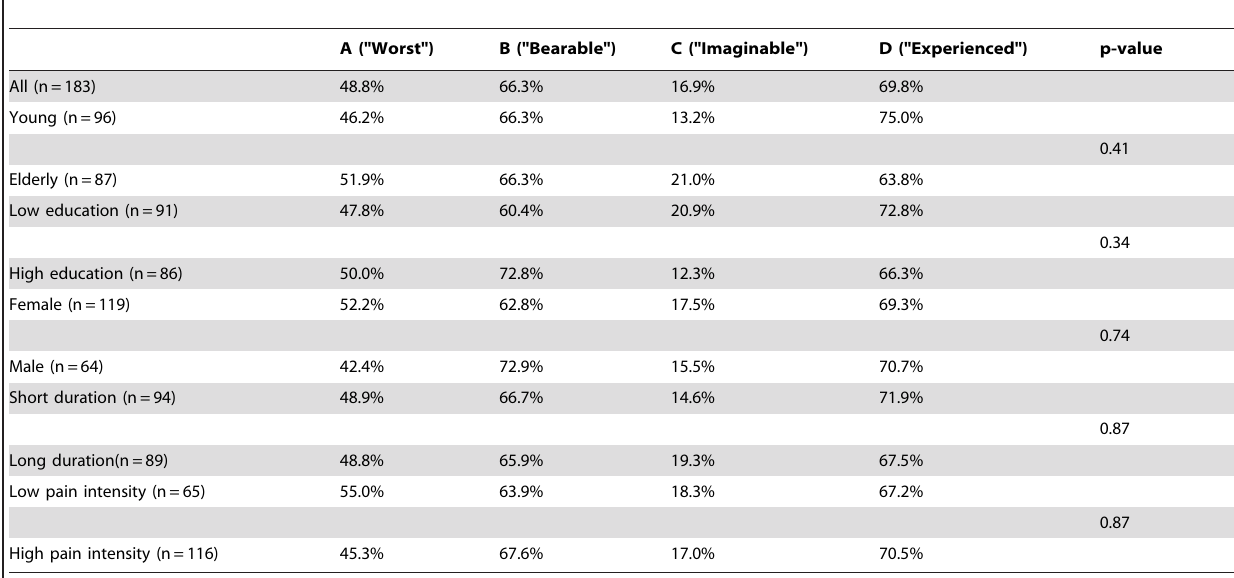
Table 2. Percentage of participants who considered each descriptor as preferable (sum of 1st and 2nd place).